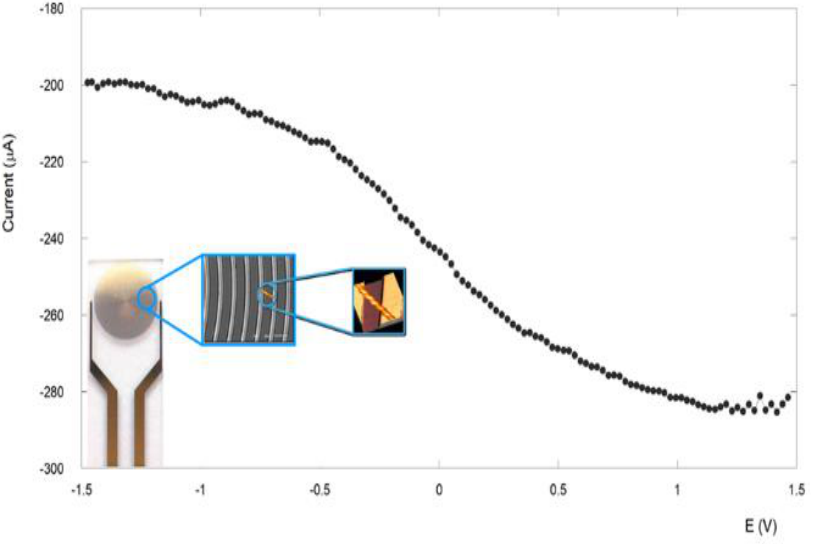
Figure 10. Typical current-voltage features of the nanofibril ropes. Inset: schematic representation of a peptide fibril across the interdigitated gold electrode. The dimension of bands/gaps of this electrode is 10 μm, while the diameter of the gold disk is 5 mm.